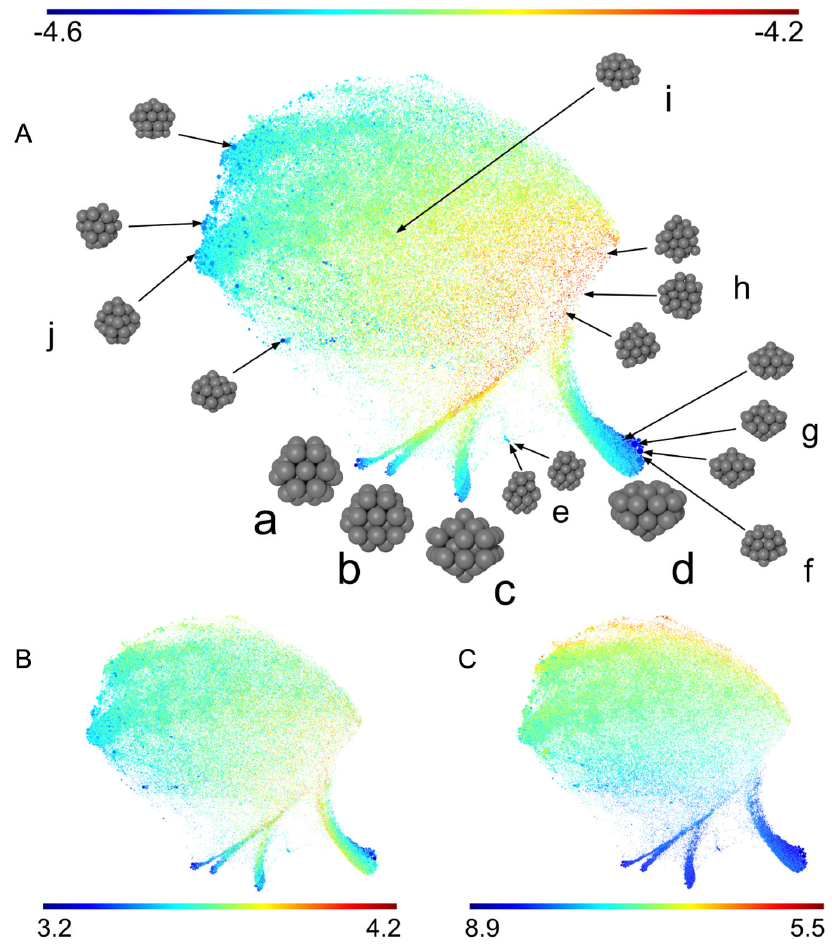
FIG. 6. (A) shows a 2D SHEAP map for 89464 minima on the LJ 38 PES, generated with RSS, described by sorted lists of all pairwise distances. The projection uses a perplexity of 30, with a minimum sphere radius R 0 ¼ 0 . 008 . The circles representing each structure are colored according to energy per atom in Lennard-Jones units; see the color bar at the top of the figure. Basin volumes are represented by the area of each circle. (a) – (d) label proposed funnels in the LJ 38 PES; structures shown alongside correspond to the lowest-energy minima residing in each. (a) contains the octahedral global minimum; (b) and (c) could be considered subfunnels of this minimum. (d) contains the icosahedral lowest metastable structure. (e) labels a small island of structures occupying the space between (a) – (c) and (d). (f) and (g) label low-energy minima residing in funnel (d) and are closely related to icosahedral structure. (h) – (j) label representative structures from the large, “ brainlike ” cluster of minima which contains the majority of structures — these are predominantly of low symmetry. (B) and (C) depict the same SHEAP map as in (A) but colored according to different physical parameters. Circles in (B) are colored according the convex hull volume of each cluster. Circles in (C) are colored according to the number of contacts per atom in each cluster (see the main text for details). Corresponding color bars are provided below these